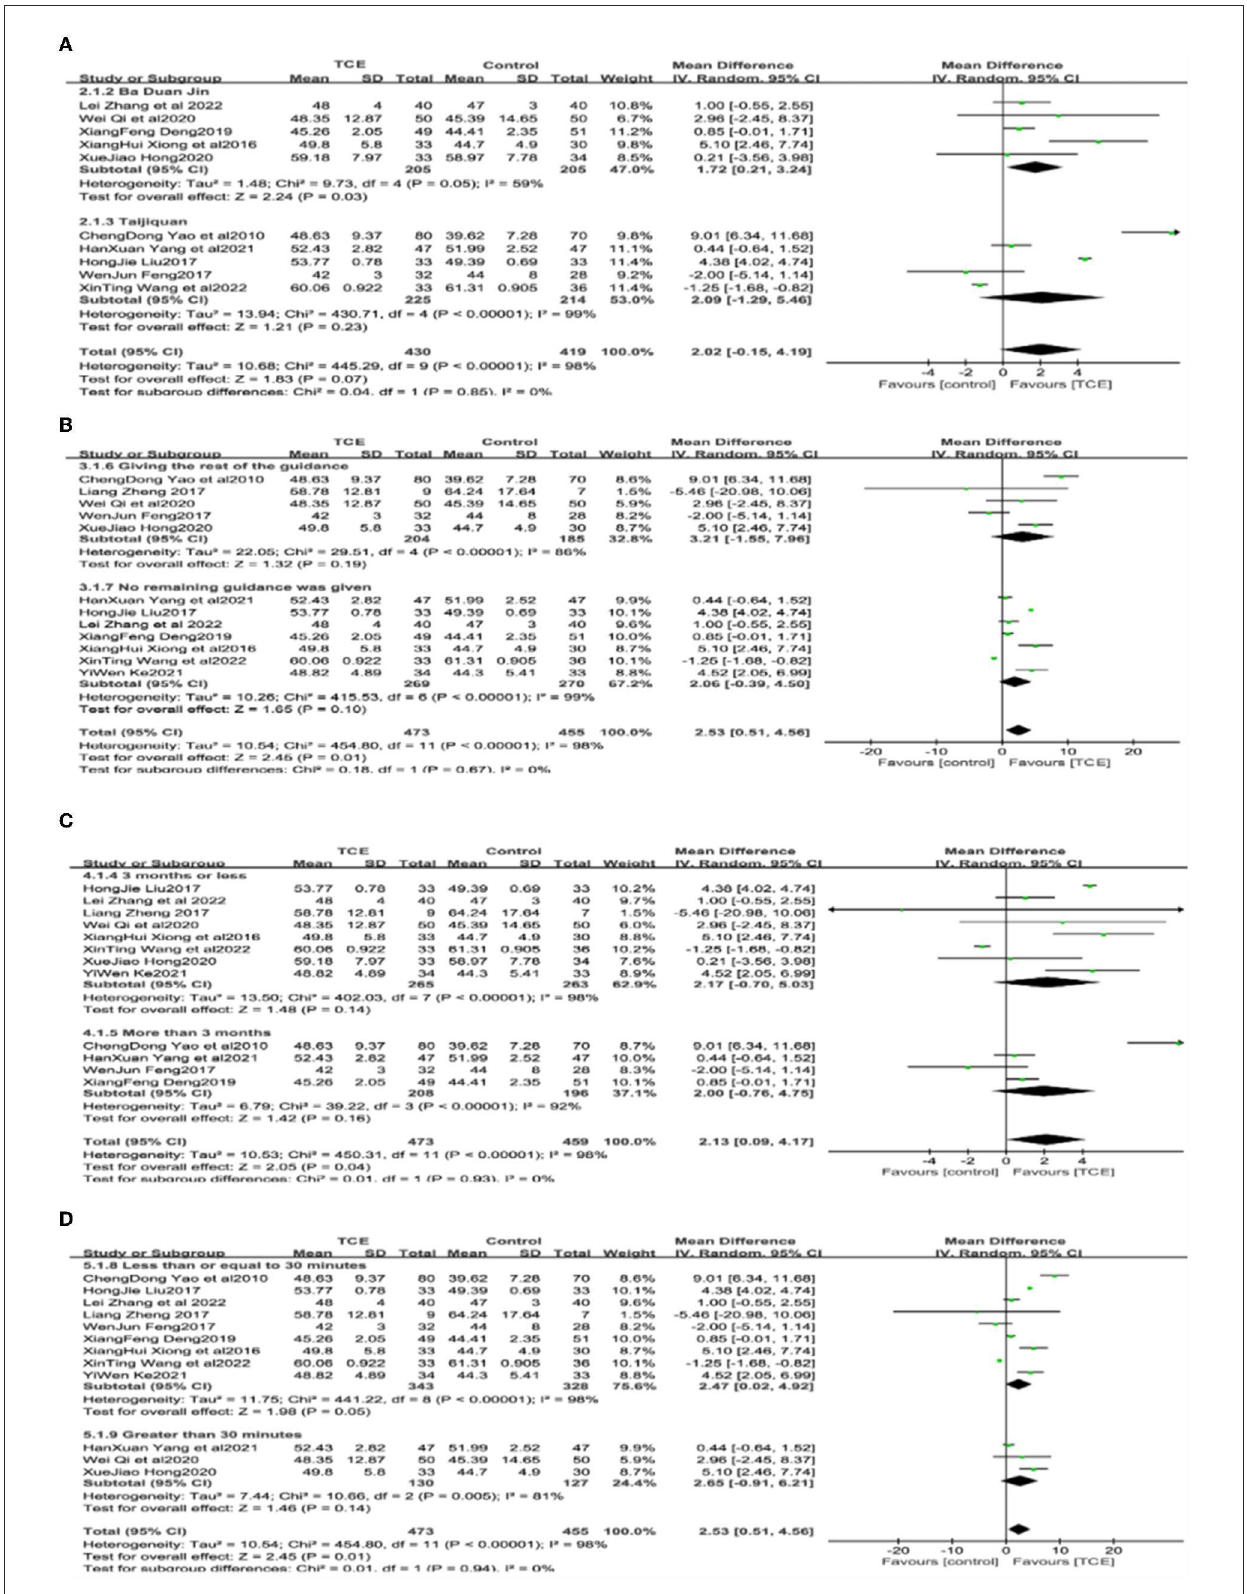
FIGURE5 (A–D) Subgroup of the effect of Traditional Chinese exercises on patients’